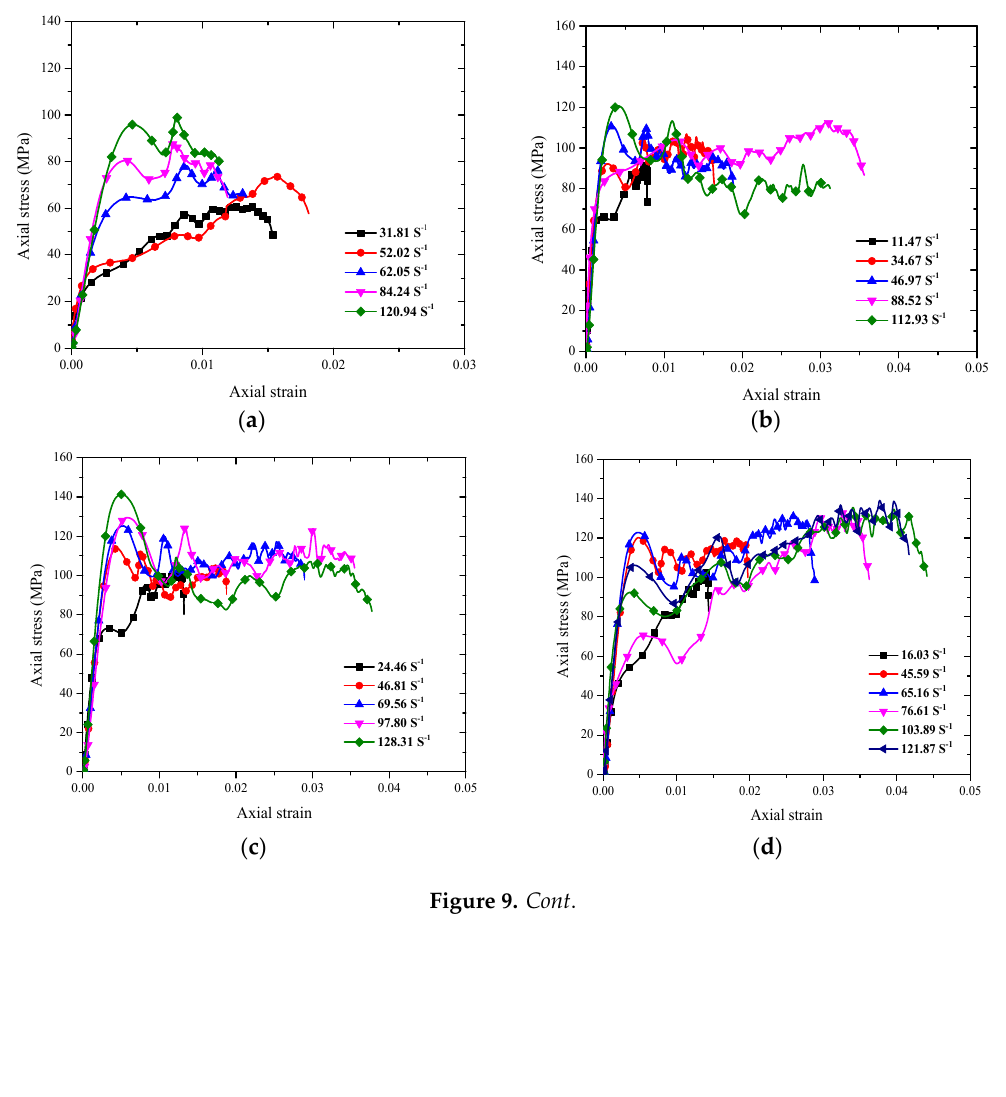
which is similar to the behavior of CFRP-confined concrete under quasi-static compression.